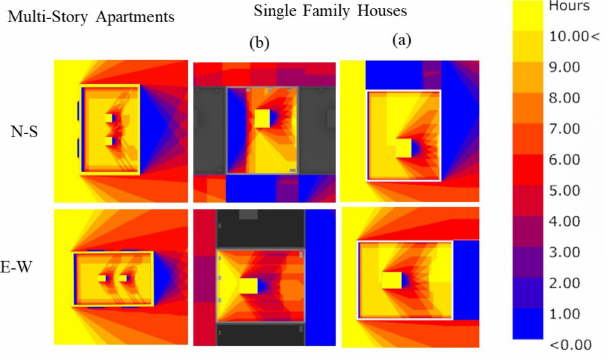
Figure 5. Shadows mesh on residential typologies roofs on solstice